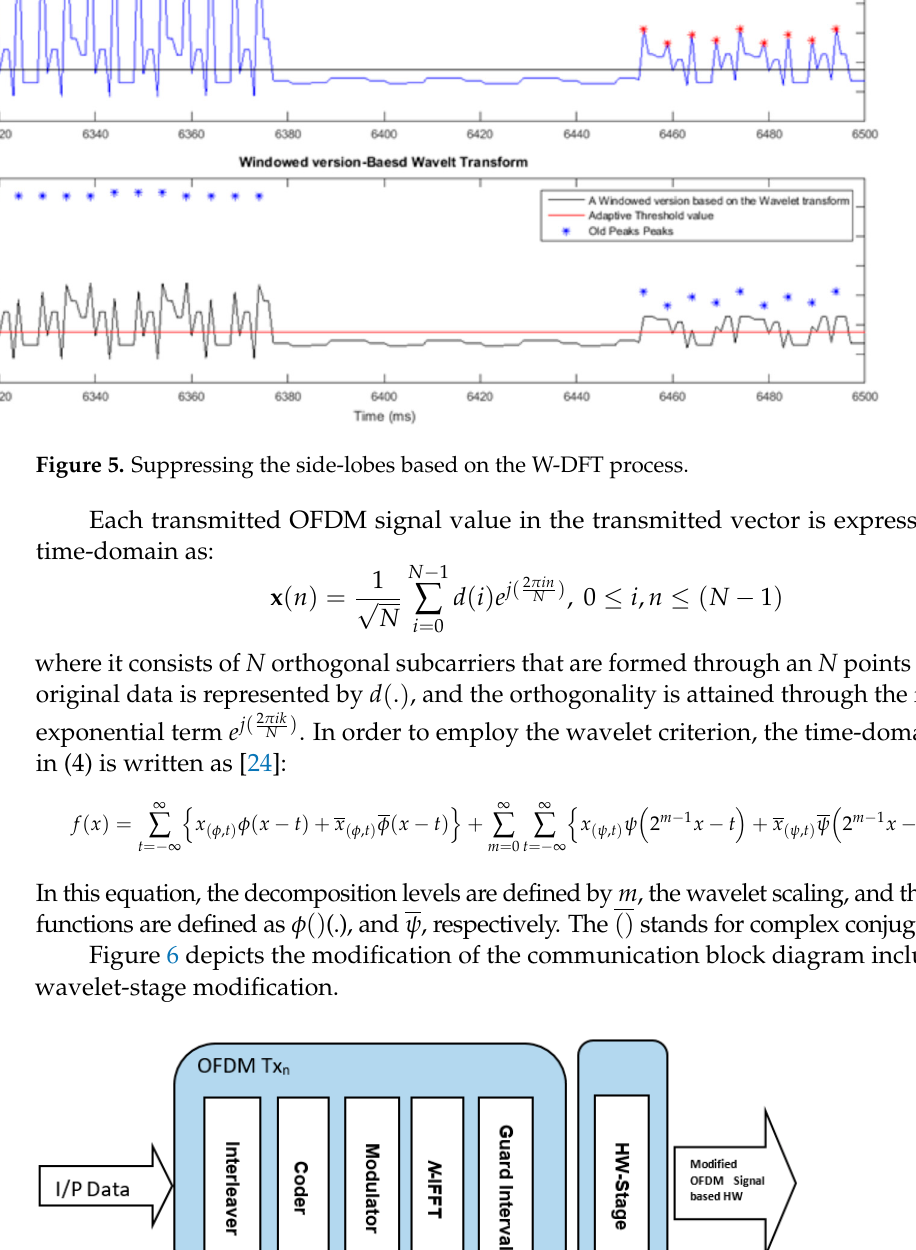
Figure 6. The communication link modification based on the wavelet-stage.